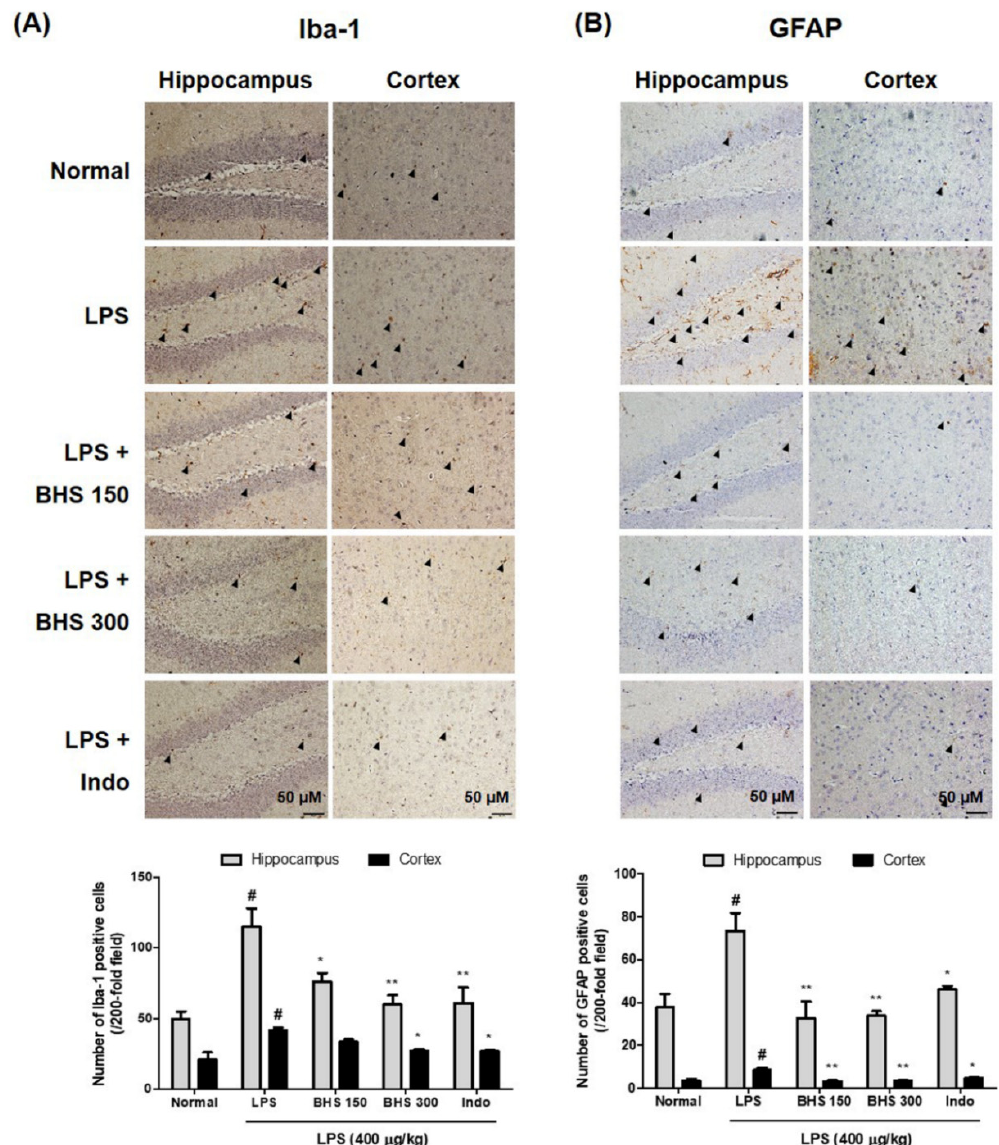
Figure 5. Effects of BHS on LPS-induced neuroinflammation in the mouse brain. Immunostaining of ( A ) Iba-1 or ( B ) GFAP proteins in the hippocampus and cortex was performed in 5- μ m sections of mouse brains with primary antibodies. Arrowheads indicate positive staining. Scale bars = 50 μ m. Data represent means ± SEM. # p < 0.05 compared with the Normal group; * p < 0.05 and ** p < 0.001 compared with the LPS group. BHS, banhasasim-tang (at 150 or 300 mg/kg per day); GFAP, glial fibrillary acidic protein; Iba-1, ionized calcium-binding adaptor molecule 1; Indo, indomethacin; LPS, lipopolysaccharide.